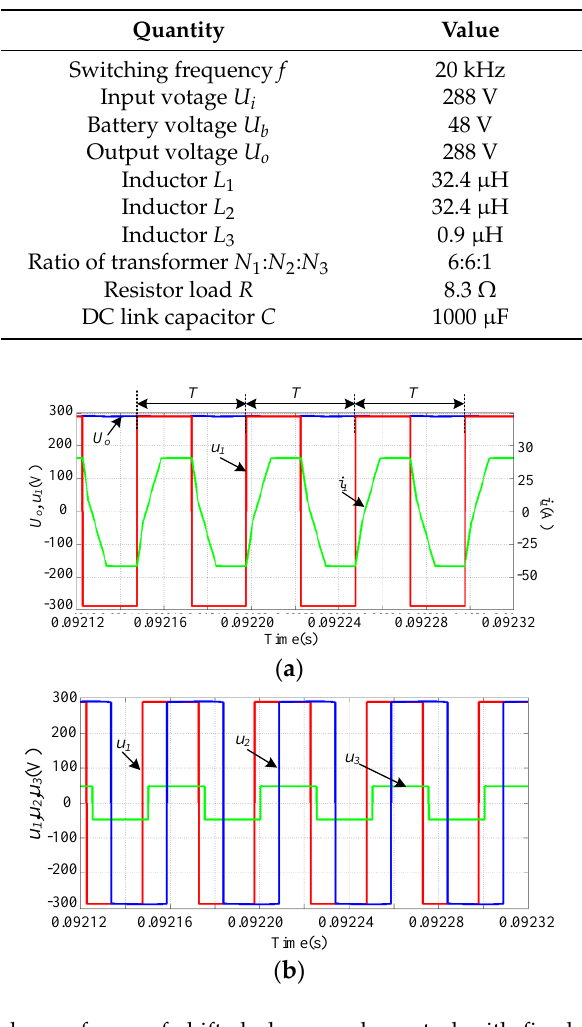
Figure 15. Simulated waveforms of shifted-phase angle control with fixed switching-frequency: ( a ) converter voltage, current of port 1 and output voltage of port 2; ( b ) converter voltages of port 1, 2 and 3.